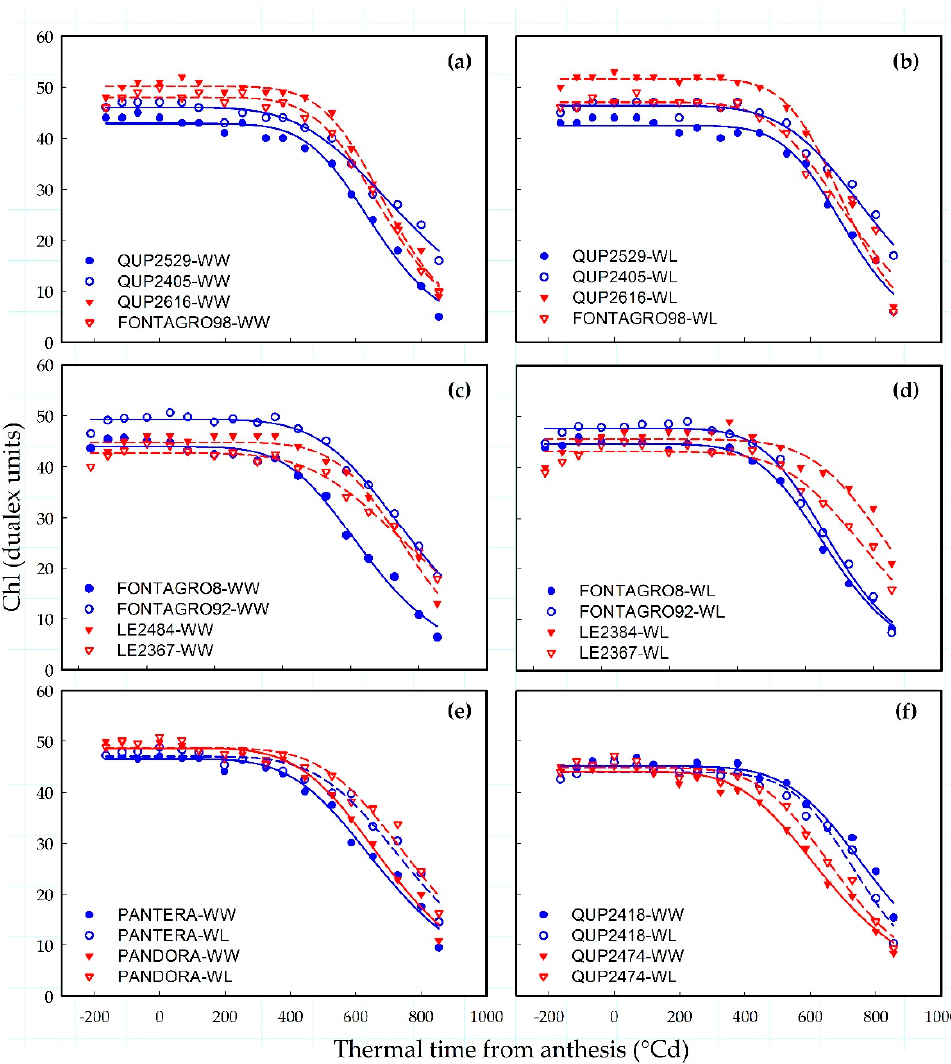
Figure 1. Dynamics of flag leaf senescence in a set of contrasting spring bread wheat genotypes from glasshouse experiment. ( a – d ) Variation among lines grown under ( a – c ) well-watered (WW) and ( b – d ) water-limited (WL) conditions. ( e , f ) Variation between water regimes. In ( a – f ), each point represents the average of four replicates but curves were fitted using individual replicates. Symbols represent measured experimental chlorophyll content index (Chl) values, whereas the lines represent the regression curves fitted with Equation (1).